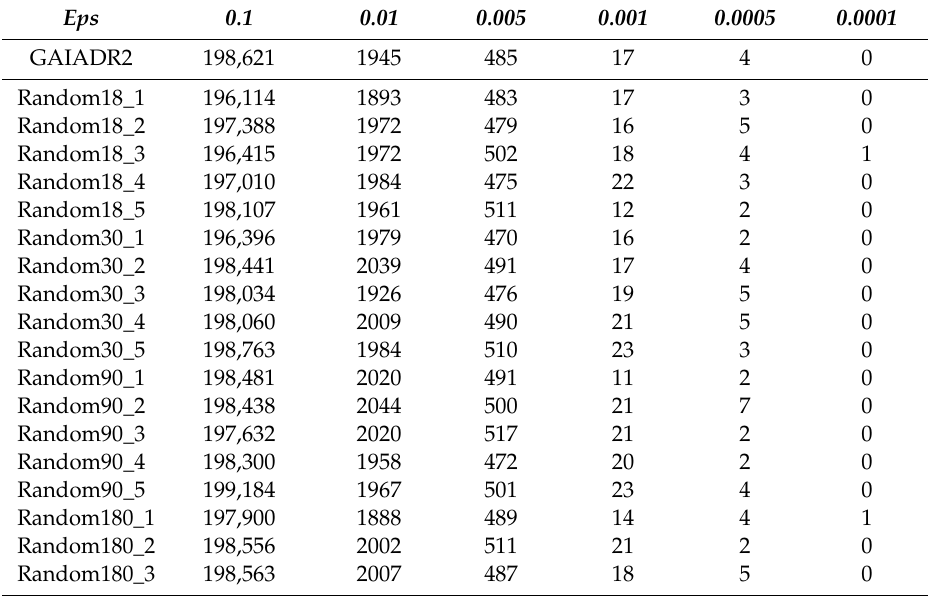
Table 21. Number of opposite pairs for selected angular accuracy values eps in the GAIA DR2 quasar catalog and in several random catalogs with the same number of objects and the same angular distribution on the celestial